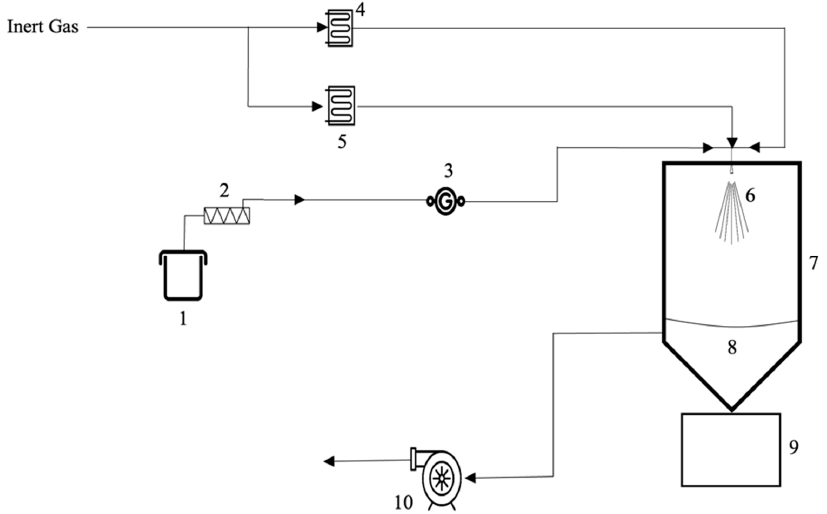
Figure 5. Schematic diagram of an electrostatic spray dryer: 1. Feed tank, 2. Pump, 3. Voltage gen- erator, 4. Drying gas heater, 5. Atomizing gas heater, 6. Electrostatic nozzle, 7. Drying chamber, 8. Separation plenum, 9. Collection vessel, 10. Blower.